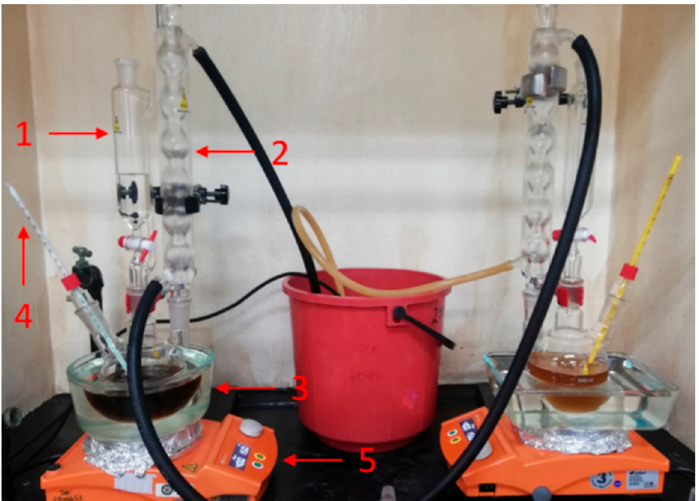
Figure 2. Experimental system reported in [11], including (1) a methanol/KOH mixture container, (2) reflux condenser, (3) heating bath, (4) temperature controller, and (5) magnetic stirrer